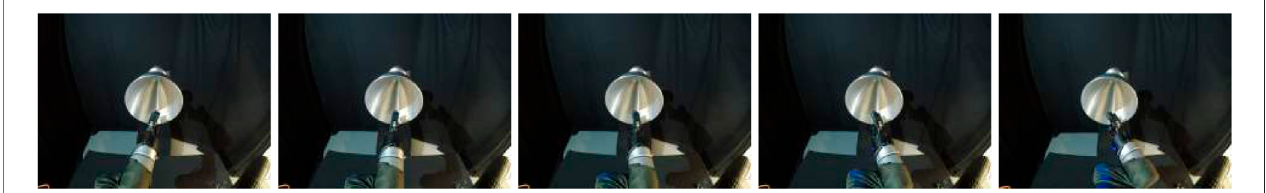
FIGURE 19 | The fi ve ψ angles used for the sensitivity experiment. From left to right: ψ (cid:1) − 20 o , − 10 o , 0 o , 10 o , 20 o .